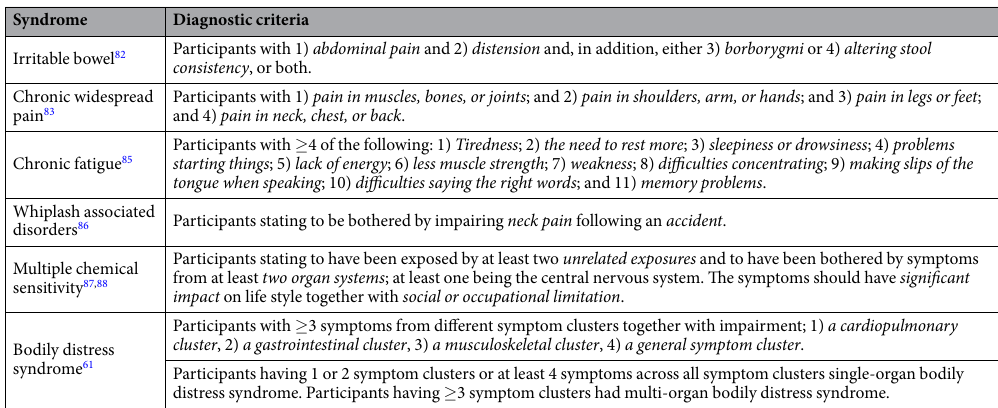
Table 4. Post-hoc diagnostic criteria of functional somatic syndromes and bodily distress